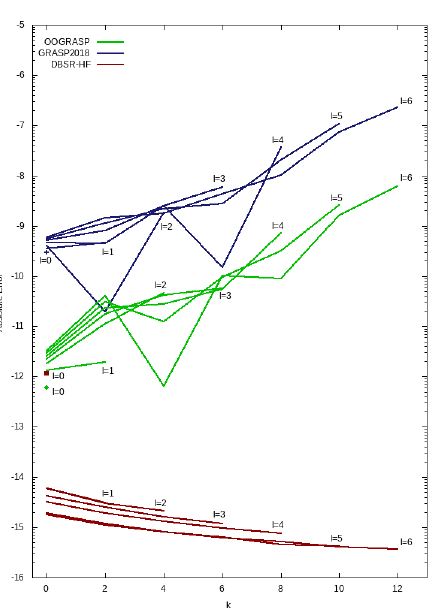
Figure 3. Figure showing the accuracy of some F k ( a , a ) integrals as a function of k for orbitals l , j = l + 1/2. All results are Z = 1 hydrogenic